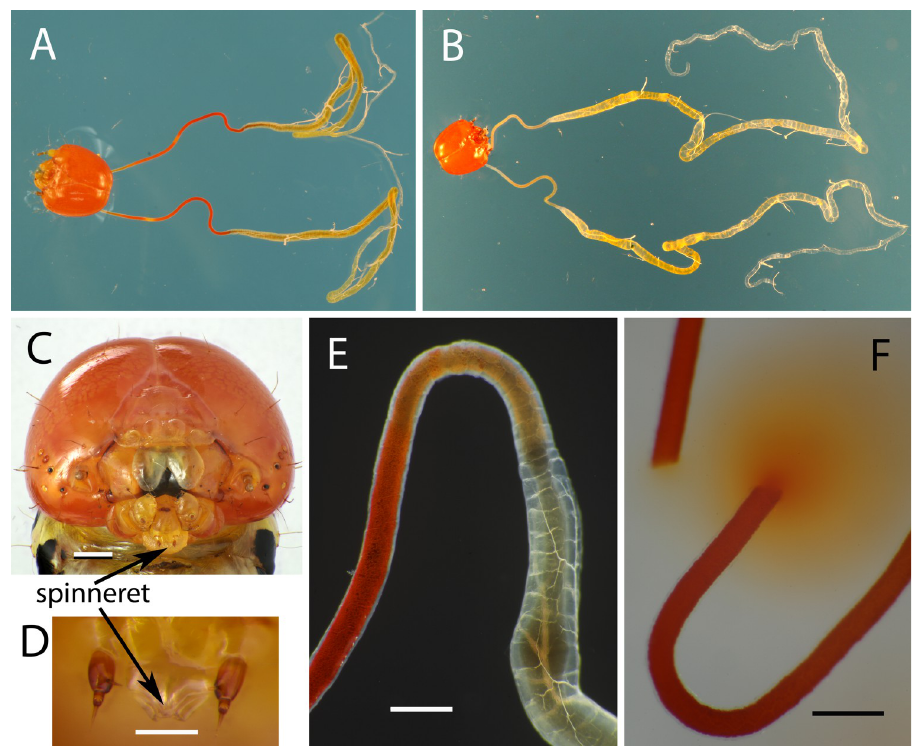
Fig 4. Labial salivary glands of Symmerista leucitys . (A) Head capsule and attached labial glands of a final instar. (B) Head capsule of a prepupa with paired labial glands that secrete the silk used in constructing a cocoon. (C) Head of a final instar with a close-up of the spinneret (D). (E) Juncture of the thin and thick portions of a labial gland from a final instar. (F) Thin portion of the labial gland from a final instar discharging its red contents after being severed. Scale bars equal 0.5 mm in C, 0.1 mm in D, and 0.3 mm in E and F.